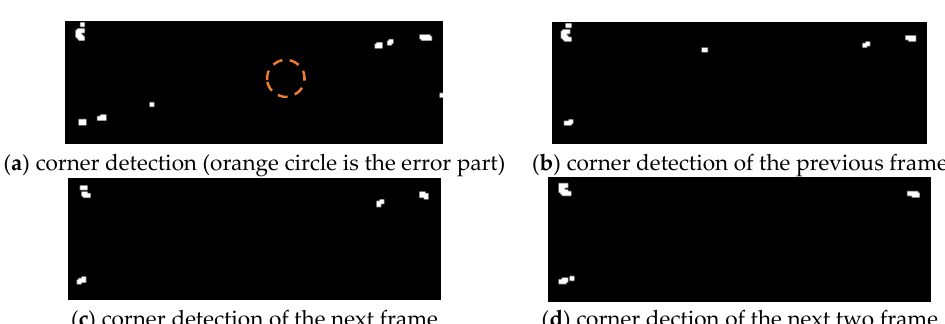
Figure 5. Results of corner detection in different images.